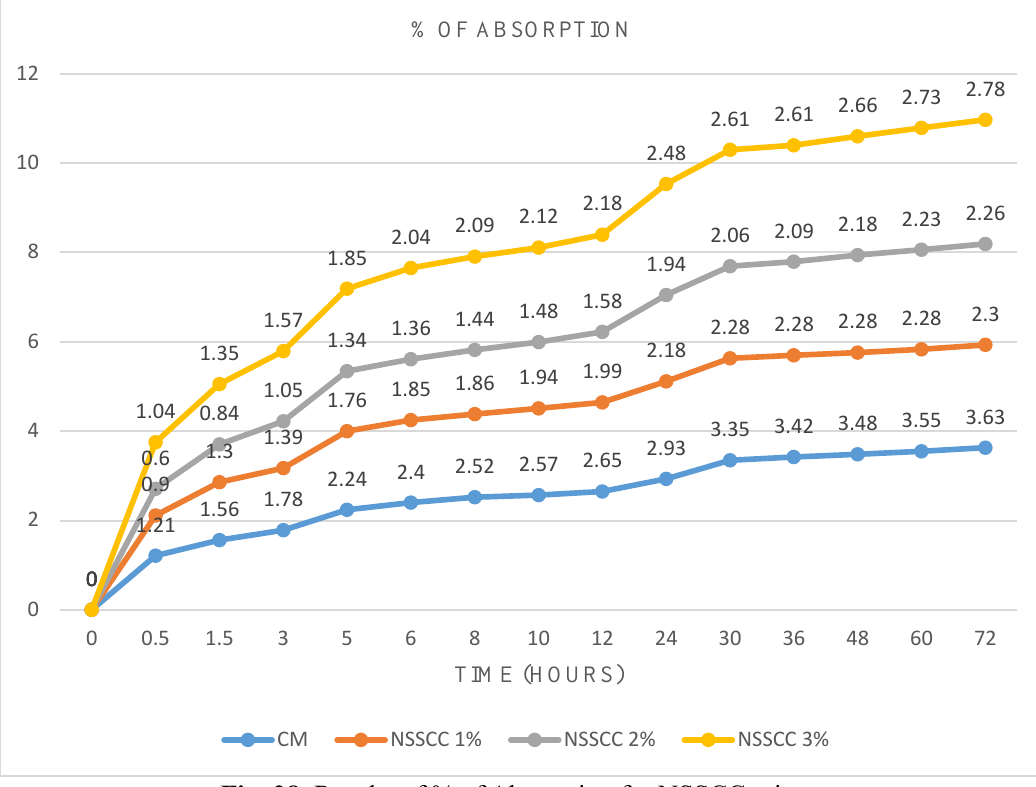
Fig. 28. Results of % of Absorption for NSSCC mixes.